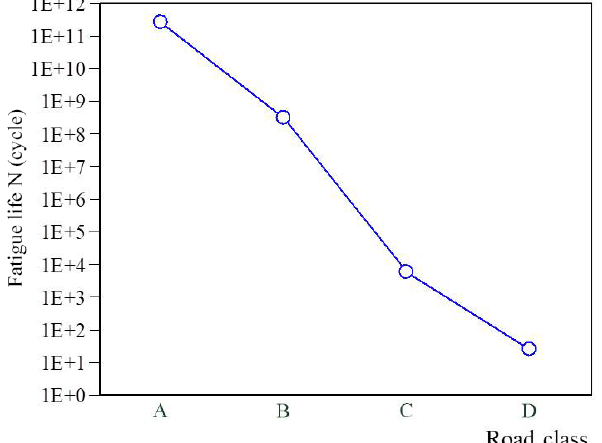
Figure 18. Fatigue life of redesigned knuckle for road classes A–D.